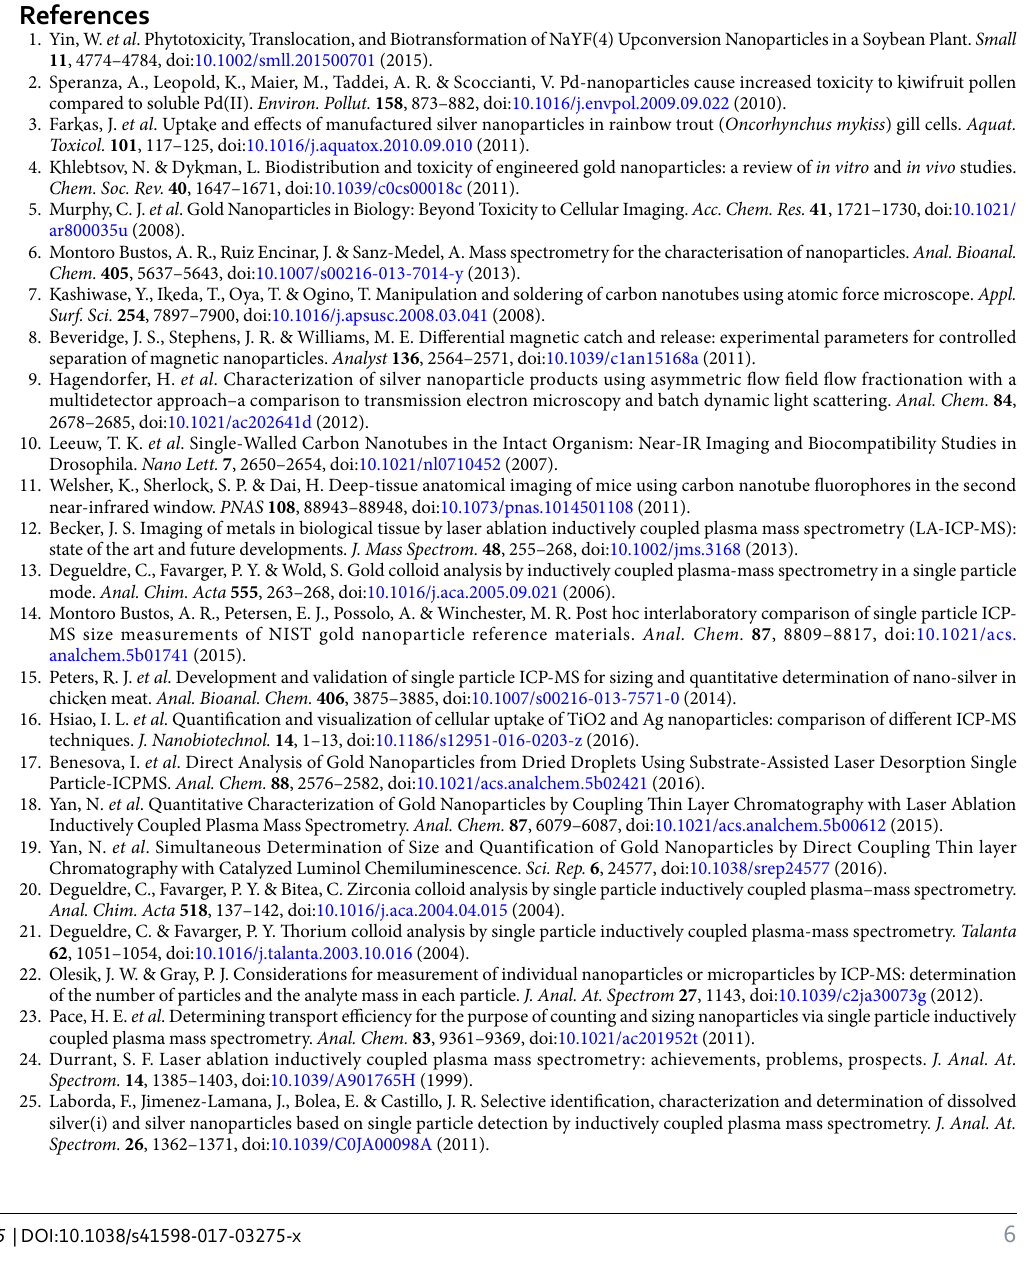
Data processing. Data were processed using Microsoft Excel to calculate particle size and determine the size distribution. Signals were isolated from the background using an iterative algorithm to qualify a given intensity as a signal 33 . For LA-SP-ICP-MS data processing, reference GNPs were used to calibrate signal intensity. The inten- sity histogram of reference GNPs was fitted with a normal distribution curve, which was used to determine the maximum signal intensity corresponding to the mean diameter of reference GNPs. A more detailed description of this process can be found in the Supplementary Information.